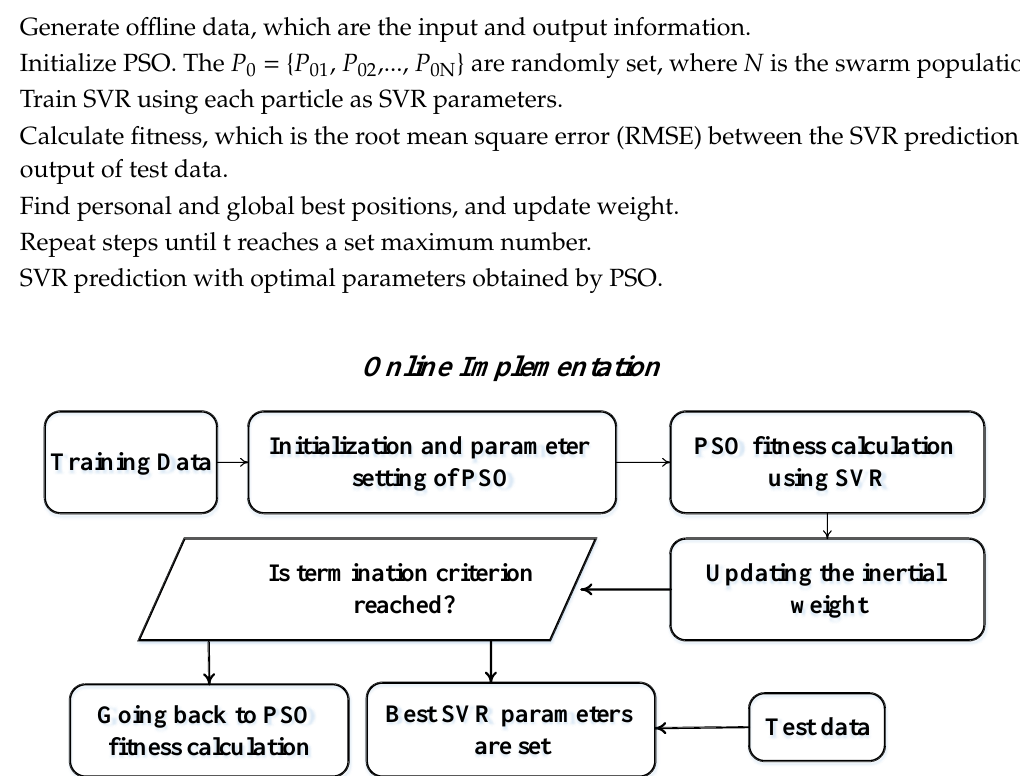
Figure 4. Process implementation diagram.